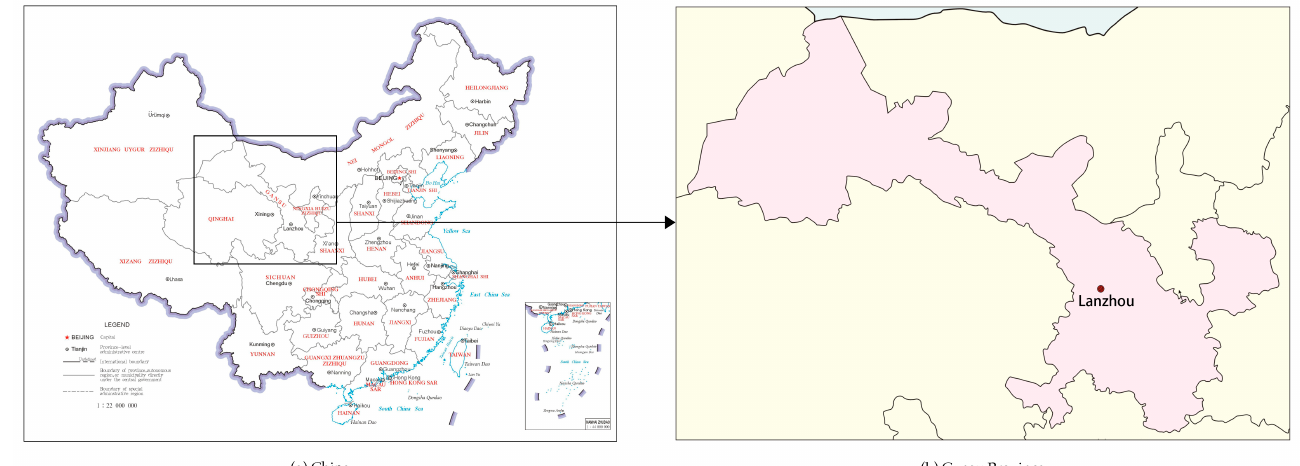
Figure 1. The geographic location of the research area.